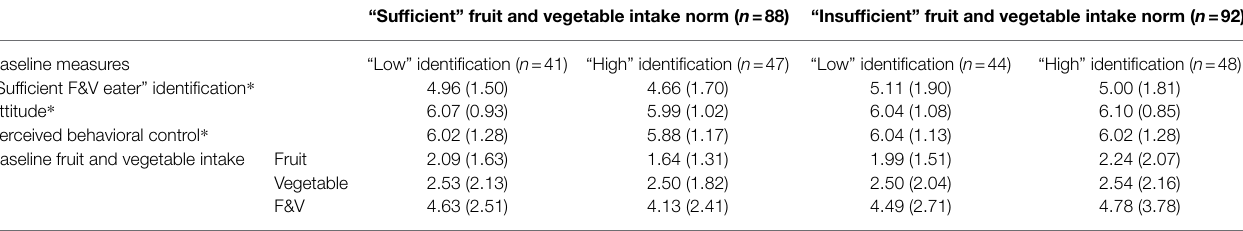
TABLE 3 | Means (and standard deviations) of baseline socio-cognitive measures and fruit and vegetable intake.